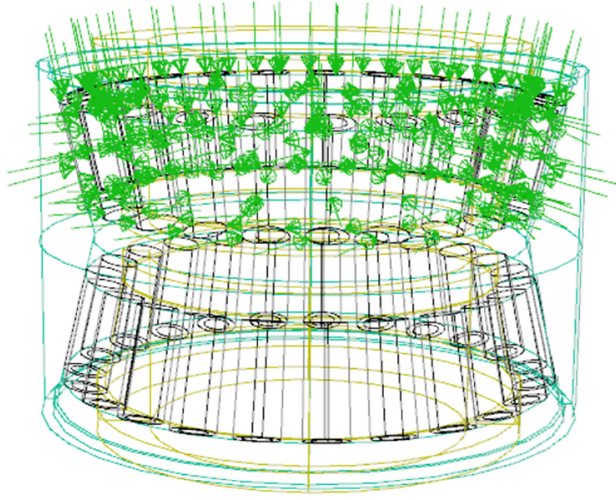
Figure 6. Heat flux density model.